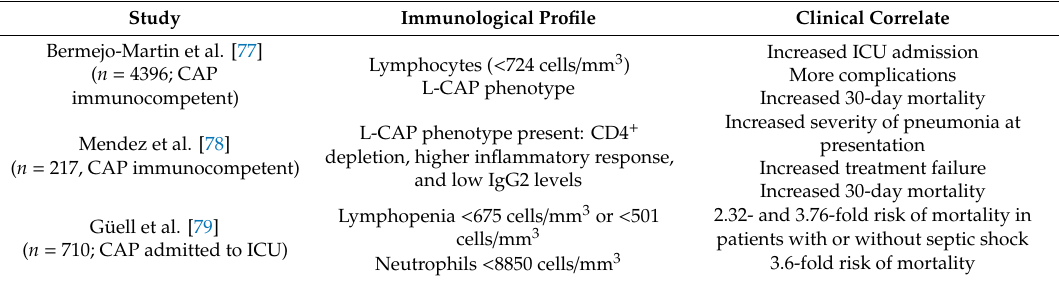
Table 1. Recent studies of immunological profiles in community-acquired